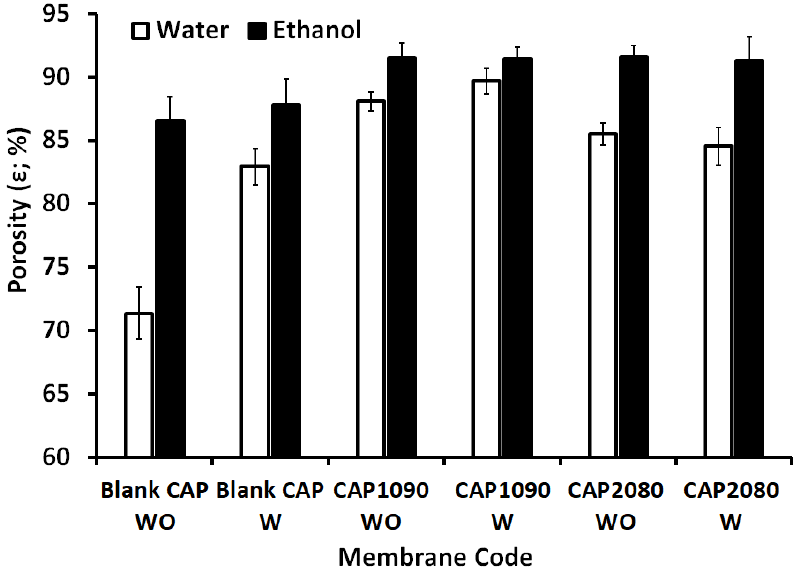
Figure 4. Porosity (%) of the blank cellulose acetate (CA) and the magnetic mixed CA matrix membranes with the absence and presence of 0.1 wt.% of lithium chloride in the membrane dope measured using absolute ethanol (black bars) and water (white bars). For all the prepared membranes, 0.8 wt.% poly(methylmethacrylate) (PMMA) was used.